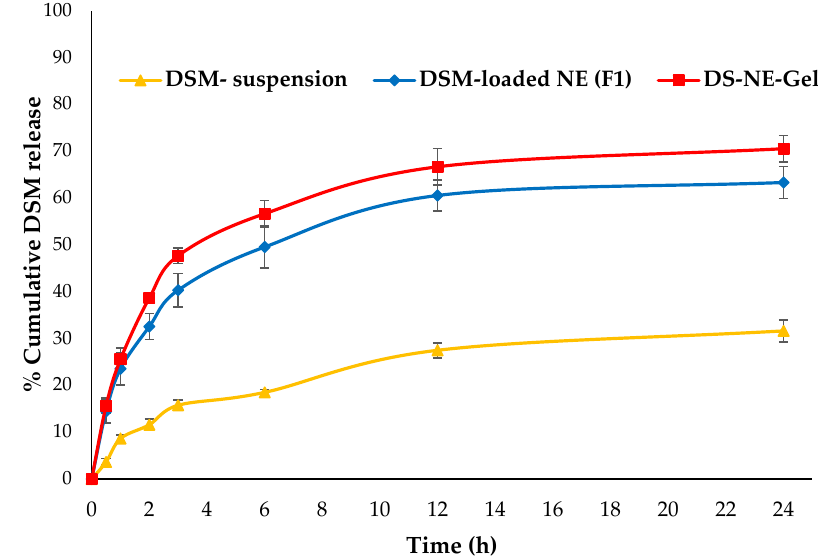
Figure 7. Comparative in vitro release profile.